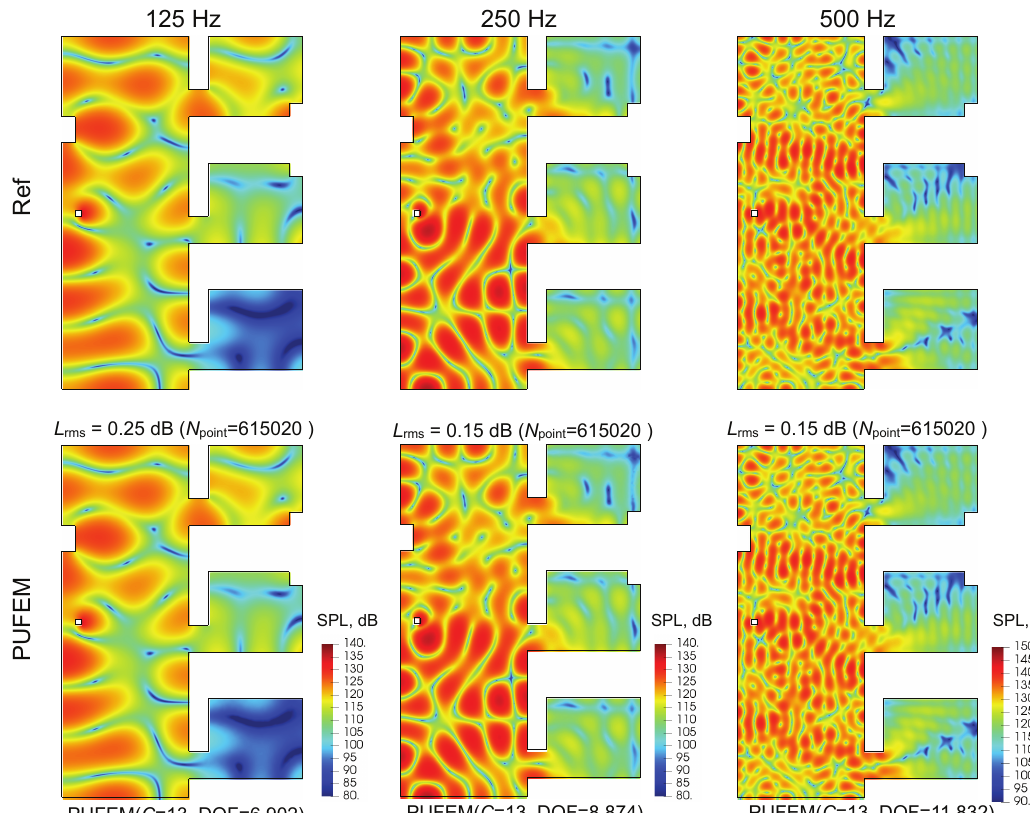
Figure 13. Comparisons of SPL distributions between Ref ( upper ) and PUFEM ( lower ) at 125 Hz ( left ), 250 Hz ( center ) and 500 Hz ( right